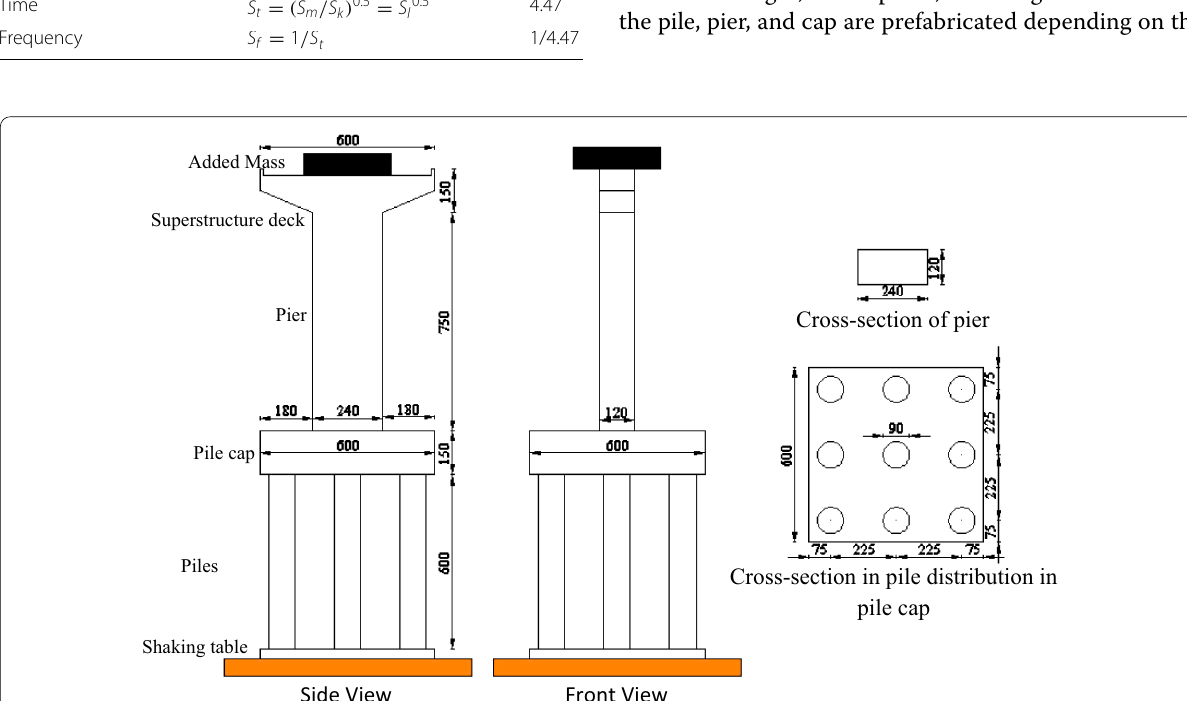
Fig. 2 Dimensions of model that inspired from selected prototype; all dimensions are in